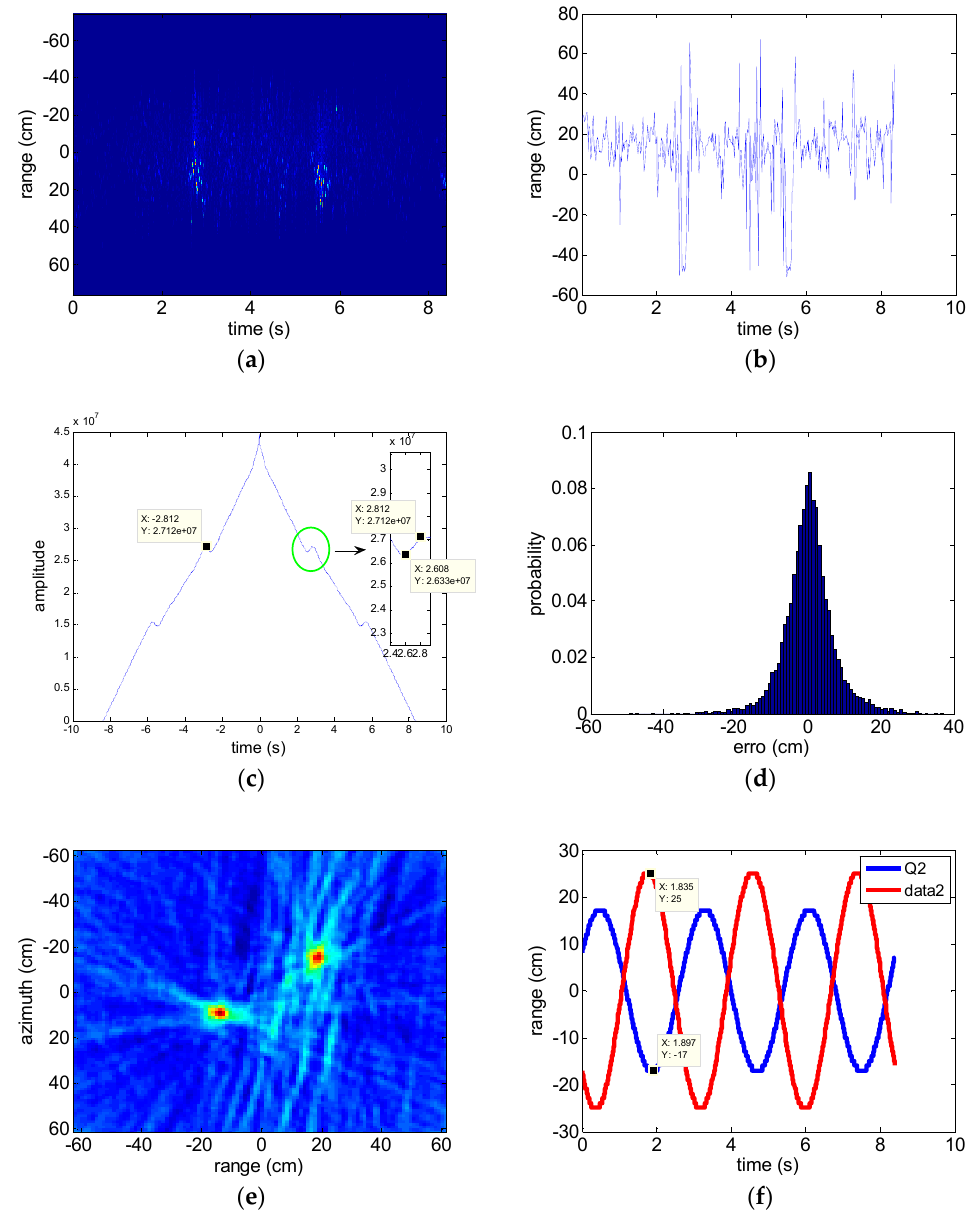
Figure 3. The results of the method proposed in this paper when reference distance is measured. ( a ) RPs contaminated by residual translational motion (SNR = 0 dB); ( b ) the modified first conditional comment of range (MFCMRP) of ( a ); ( c ) the autocorrelation result of ( b ); ( d ) the relationship between translational motion estimation errors and occurrence probabilities; ( e ) inverse radon transform (IRT) result of compensated RPs; ( f ) the parameter of rotational motion estimated by ( e